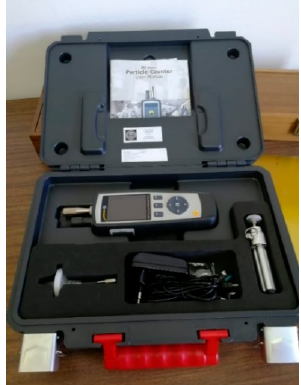
Figure 5. Detail of the particle counter PCE-PCO1 manufactured by PCE instruments.